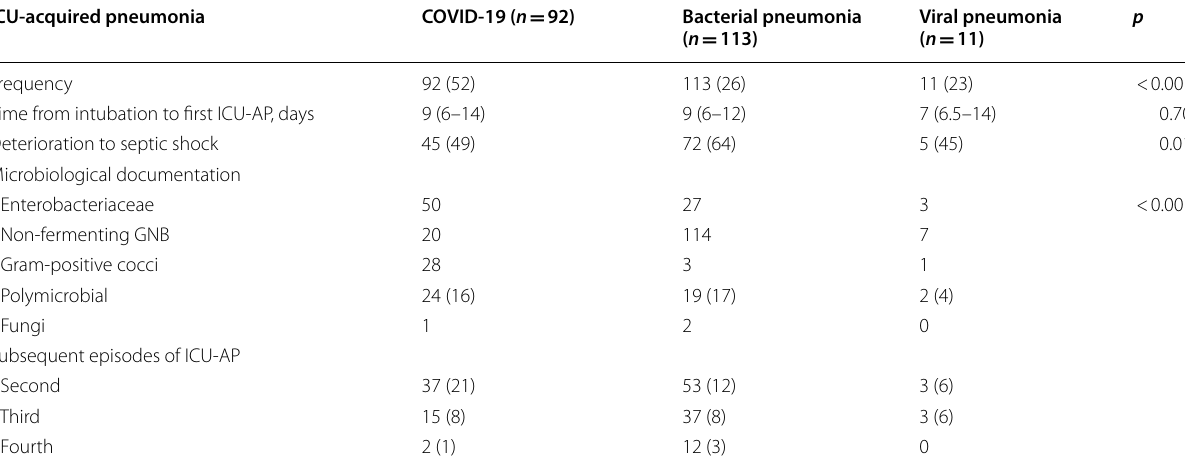
ICU, intensive care unit, ICU-AP, intensive care unit-acquired pneumonia. Variables are expressed as median (interquartile range) or number (percentage) as appropriate